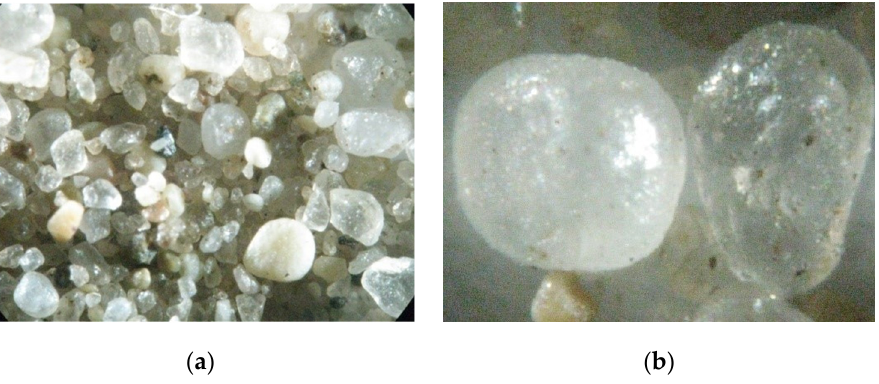
Figure 10. Particle morphology of the Xiaoluan River sediment. ( a ) Particle morphology at 300× magnification ( b ) Particle morphology at 1200× magnification.